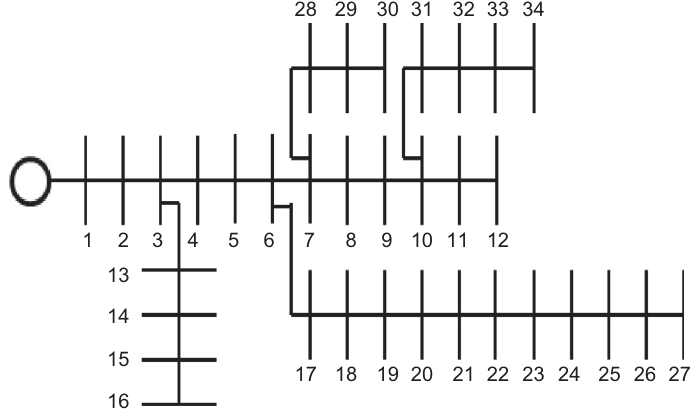
Figure 1. Schematic interconnection among nodes in the IEEE 34-bus system. Figure 4 IEEE-34 bus radial distribution test system.